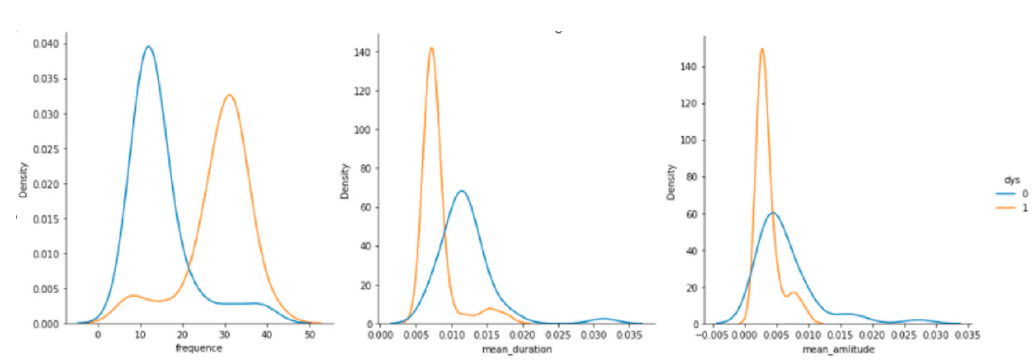
Figure A5. Distribution of the DGI for the painting 1 dataset.